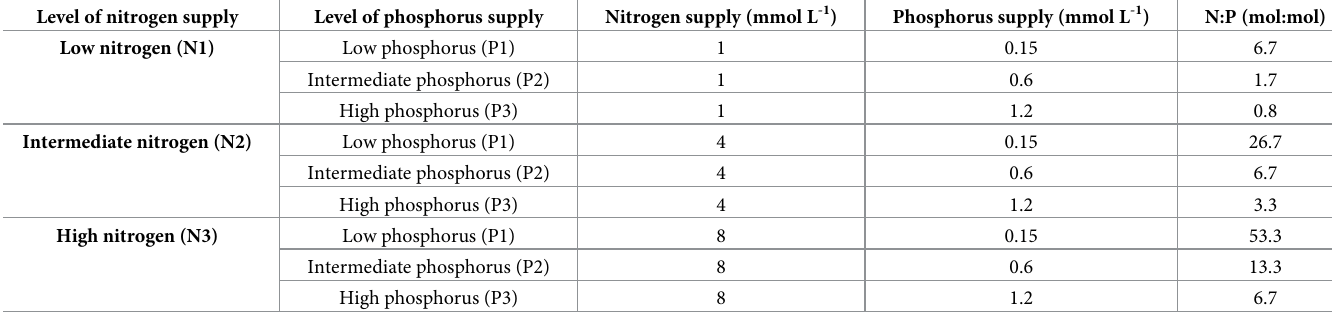
Table 1. Nitrogen and phosphorus supply used in the experiment. Level of nitrogen supply Level of phosphorus